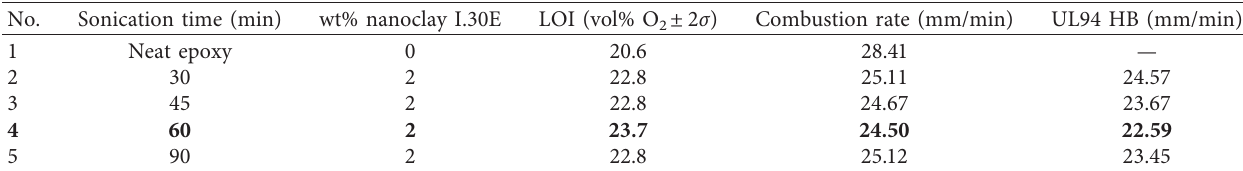
Table 8: Effect of ultrasonic stirring time on fire retardation of epoxy Epikote resin 240/nanoclay I.30E nanocomposite material.